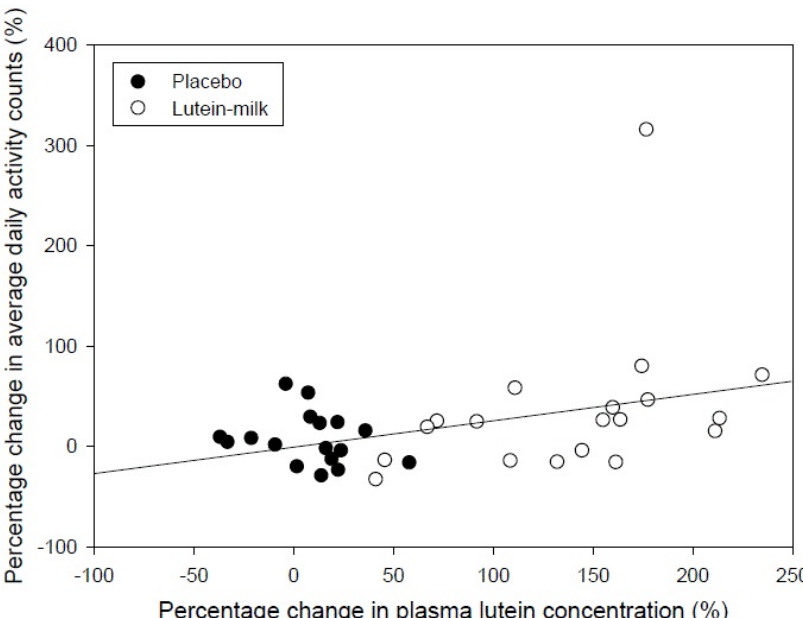
Figure 3. Relationship between percentage change in plasma lutein concentration and percentage change in average activity counts determined using